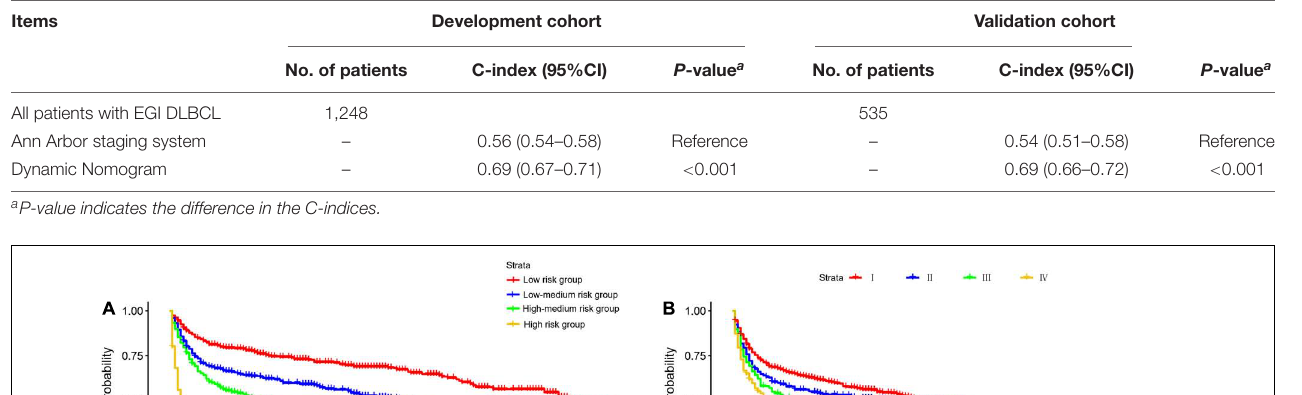
predict the possible incidence of different survival periods based on the total